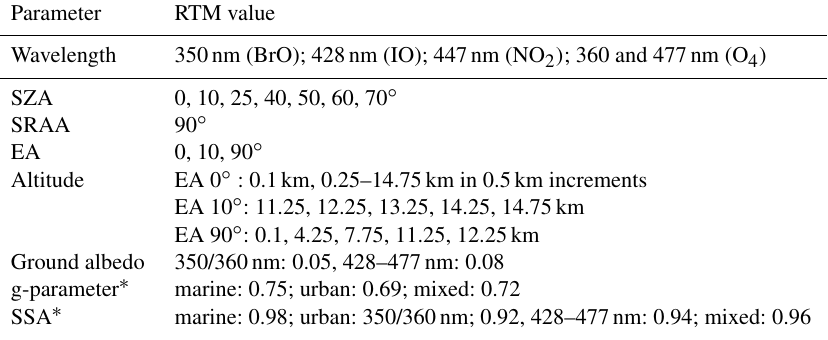
Table 1. RTM settings.